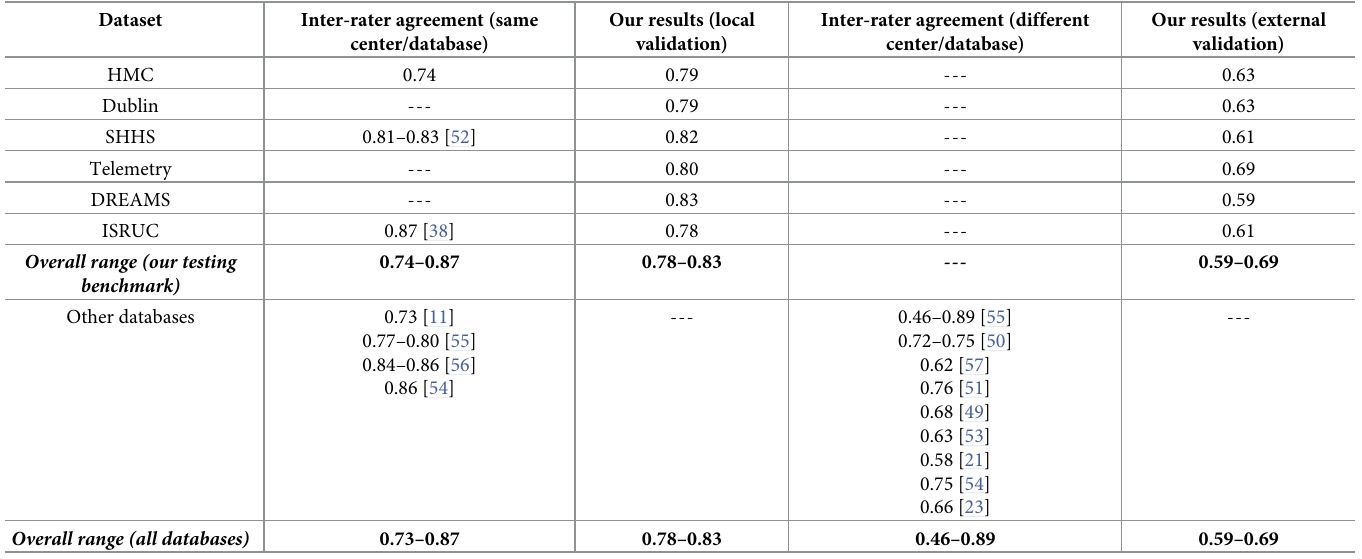
Table 5. Indices of human inter-rater agreement reported in the literature compared with the performance achieved by our proposed deep-learning